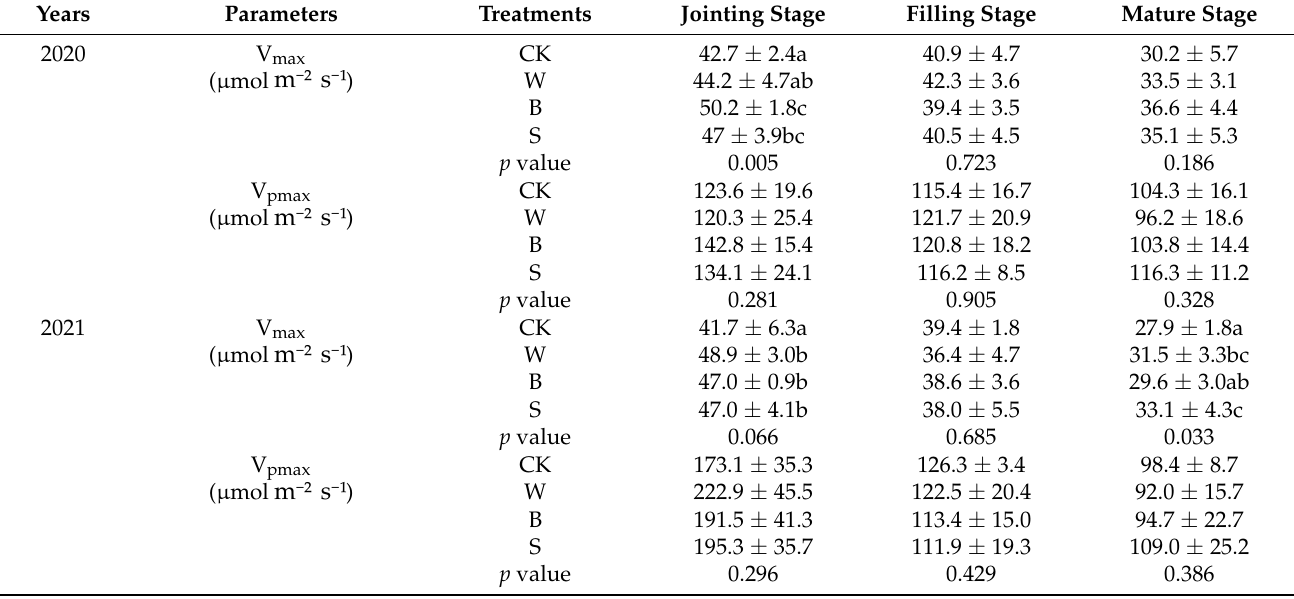
Table 3. Changes in photosynthetic capacity among